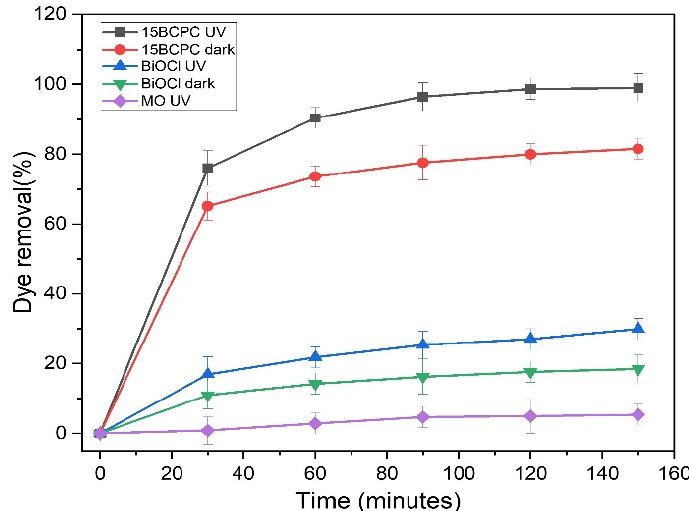
Figure 8. The MO removal under controlled conditions.